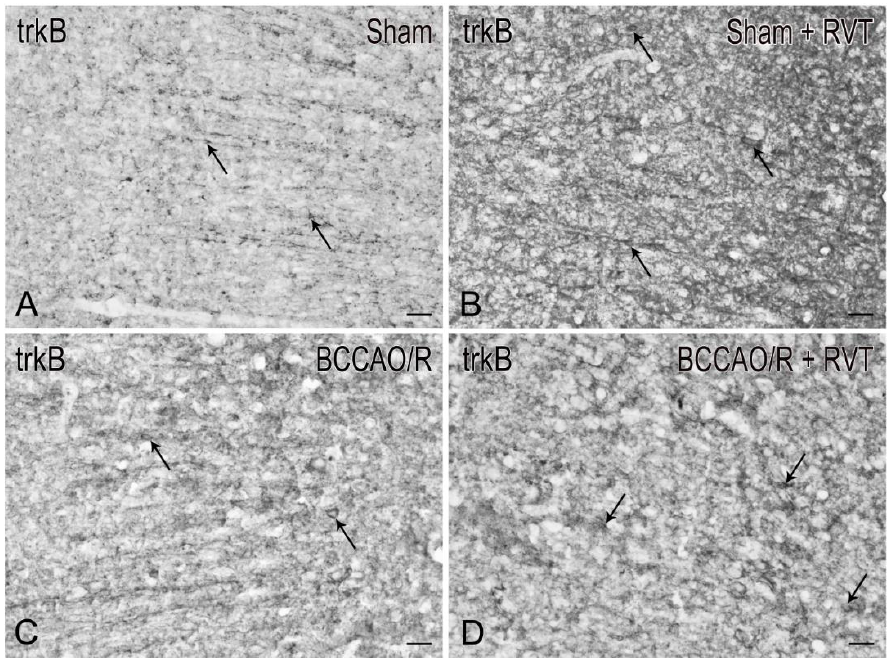
Figure 3. Tyrosine kinase receptor B (trkB)-like immunoreactivity in coronal sections of frontal cortex of sham-operated and bilateral common carotid artery occlusion followed by reperfusion (BCCAO/R) rats pre-treated with either the vehicle alone ( A , C ) or with resveratrol (RVT) ( B , D ). Positive neuronal processes, punctate elements, and neuronal perikarya are distributed across the whole thickness of the cortex. Arrows point to immunostained neuronal perikarya. Panels are representative of observations carried out in 6 rats for each group. Scale bars: 25 µm.